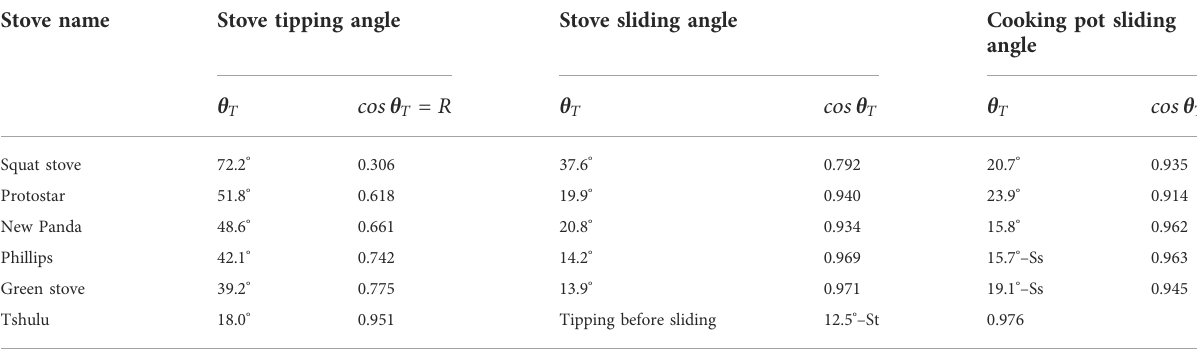
TABLE 3 Results of tipping, sliding, and spilling tests on South African stoves in various con fi gurations with or without a pot in place.